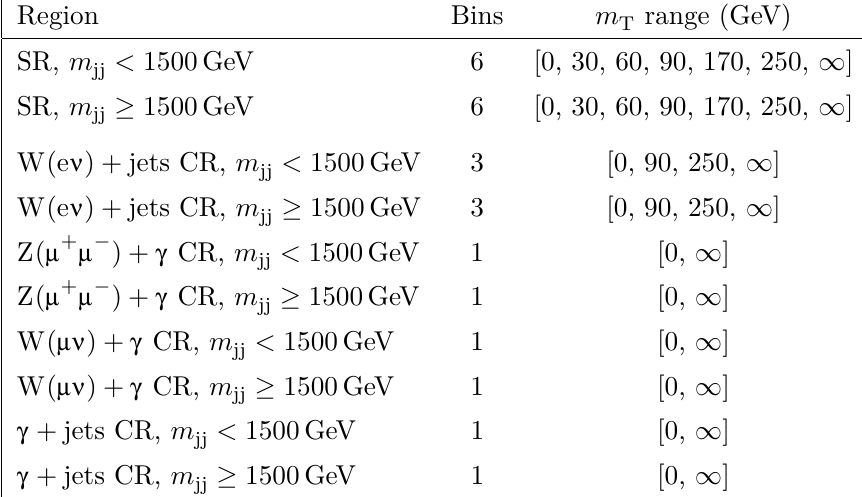
binning choice in the SRs and T